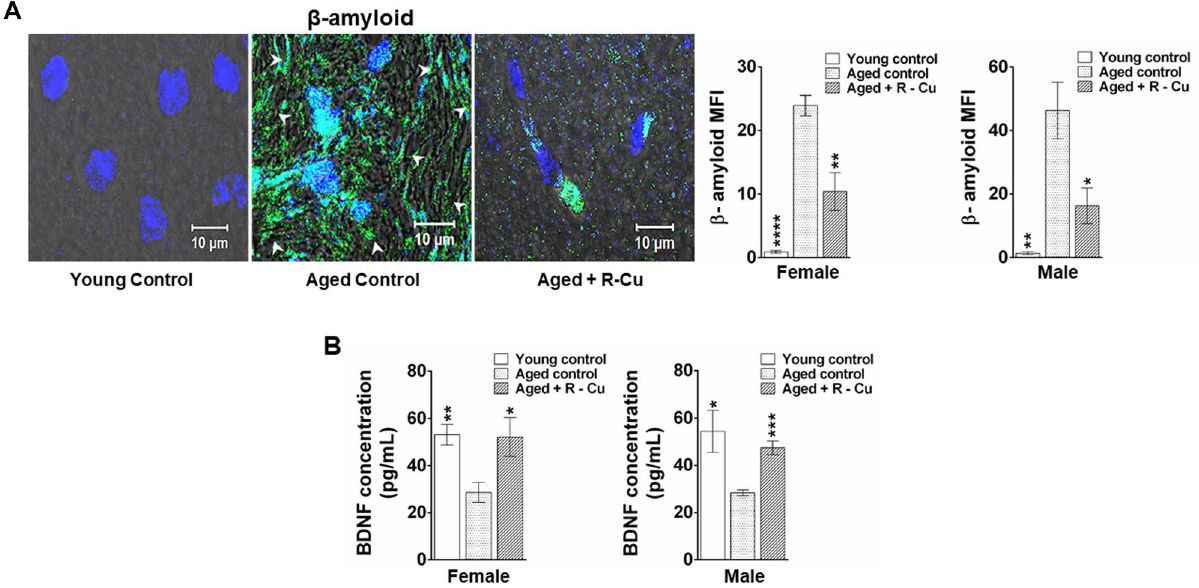
Figure 4. Increased β- amyloid deposition in ageing brain and reduced BDNF in serum, both of which are reversed by treatment with R–Cu. ( A ) Representative confocal images of β- amyloid deposition in brain as detected by IF (left hand panel). Quantitative histograms representing mean MFI values (± SEM) of β- amyloid fluorescence (right hand panel). For each slide, brain area covered by 1000 cells were analysed. N = 4 animals in each group of both sexes. ( B ) Quantitative histograms representing mean serum BDNF levels (± SEM). N = 4 animals in each group of both sexes except, young control female (N = 3), ageing R–Cu treated female (N =